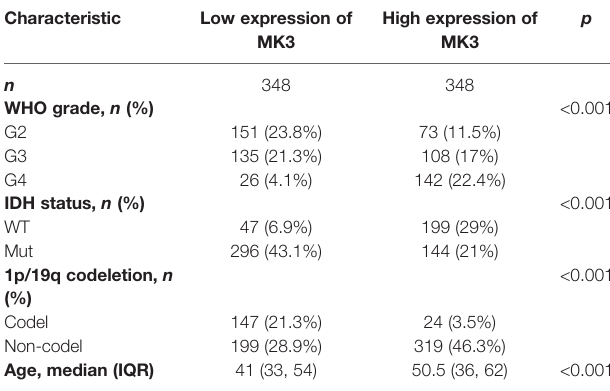
TABLE 2 | The association between MK3 expression and the clinical parameters in glioma patients in TCGA.